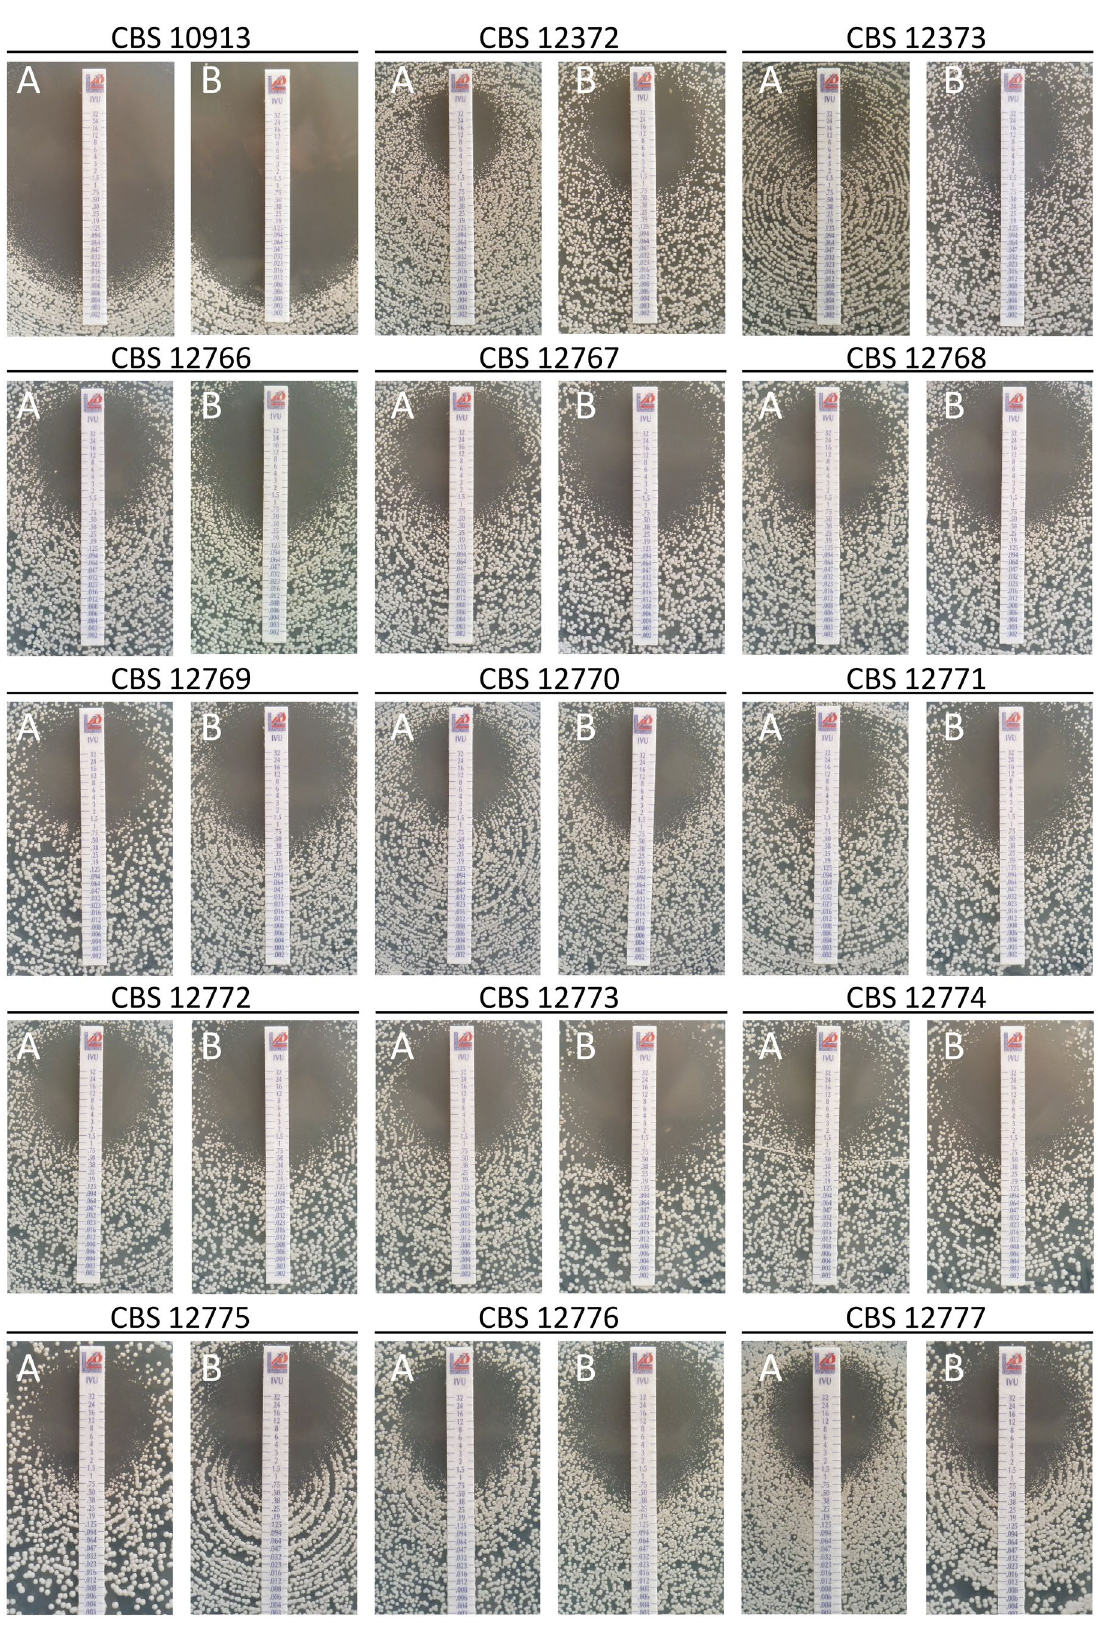
Figure 2. Agar diffusion assay for the 15 isolates. ( A ) Panels: isavuconazole alone; ( B ) panels: isavuconazole + colistin at 64 µg/mL incorporated in the agar. Colistin alone at 64 µg/mL incorporated in the agar did not inhibit the growth of any of the isolates (pictures not